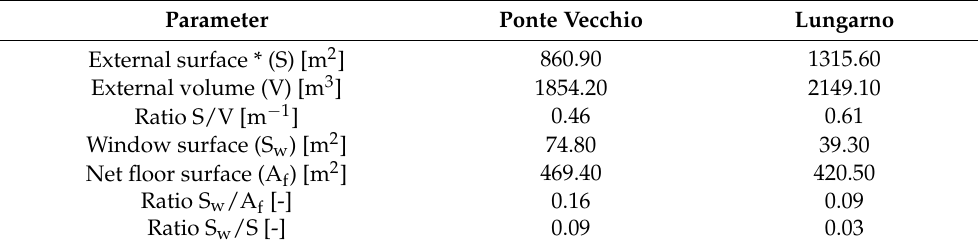
Table 1. Geometric data of the Ponte Vecchio and Lungarno thermal zones of Vasari Corridor.